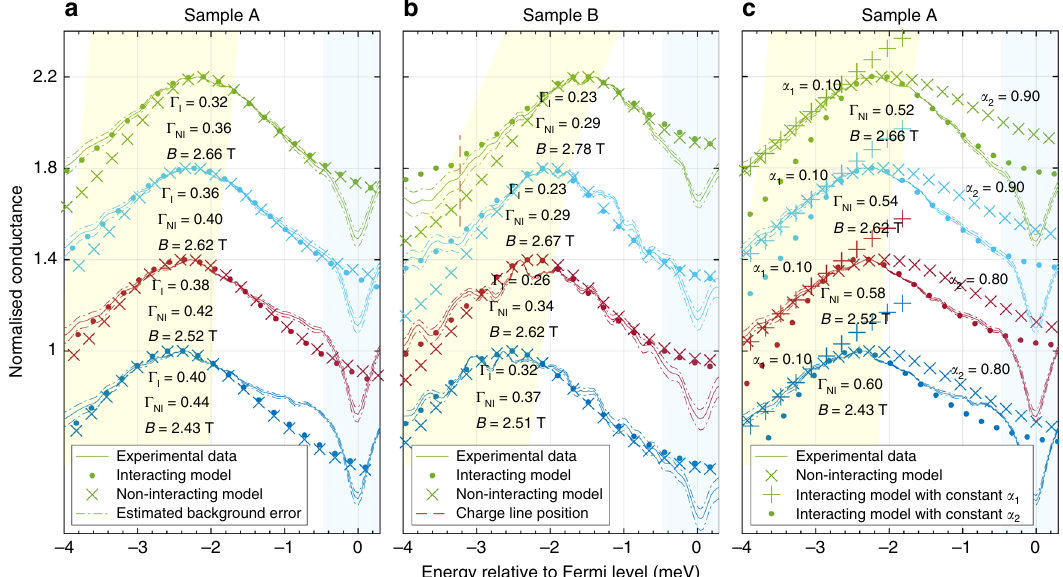
Fig. 4 Fitting results showing the interaction-induced enhancement to the left of the peak. Fits to the conductance for ( a ) sample A and ( b ) sample B, normalised to their peak values and shifted vertically for clarity, for model 1 (crosses) and model 2 (dots). The dashed lines show the con fi dence interval of the measurement data within estimated error of the background conductance subtraction. The broadening fi tting parameters for the non-interacting and interacting models ( Γ NI and Γ I , respectively) are shown, in units of millielectronvolts, together with the B fi eld at which the data were taken. Sample A (wires 18- µ m long) was measured at 50 mK in a He 3 /He 4 dilution refrigerator, while sample B (10- µ m long) was measured at 330 mK in a He 3 cryostat. c Fits using other theories, or matching different parts of the data using different constant exponents α 1 and α 2 , as labelled (using data for sample